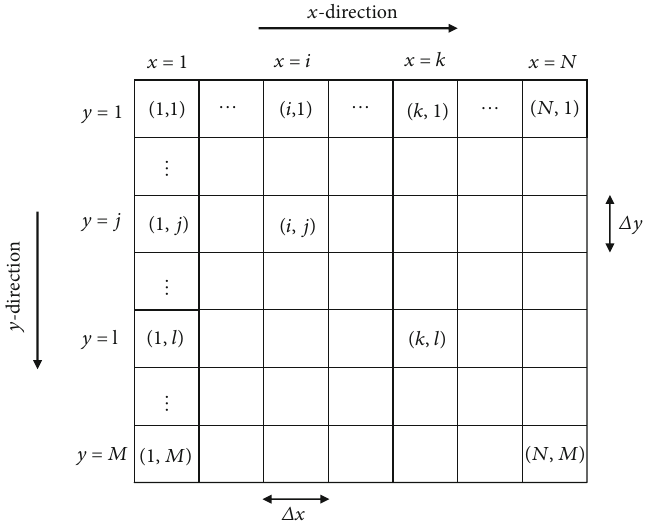
Figure 6: Illustration of the grid discretization and discretized Boussinesq equation. Indices i and k represent the coordinates in the x direction, with 1 ≤ i ≤ N and 1 ≤ k ≤ N . Indices j and l represent the coordinates in the y direction, with 1 ≤ j ≤ M and 1 ≤ l ≤ M . In Þ z direction elastic displacement on grid ð i , j Þ . Δ x Equation (13), the vertical pressure p k is applied on grid ð k , l Þ , and ð u i , j represents the e , l and Δ y are the grid sizes in the x direction and the y direction,